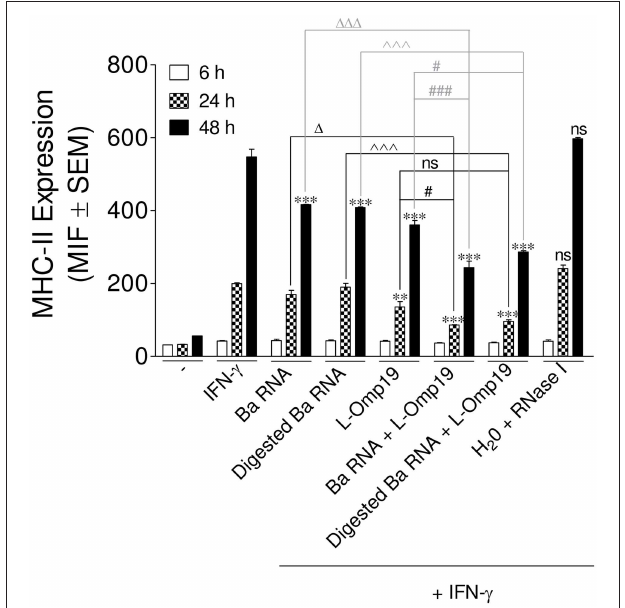
FIGURE 6 | MHC-II down-modulation begins after 24h post-stimuli. THP-1 cells were treated with B. abortus RNA (10 µ g/ml), digested B. abortus RNA, L-Omp19 (1 µ g/ml) or their combination in the presence of IFN- γ for 6, 24, and 48h. Cells treated with RNase I were used as a control. MHC-II expression was assessed by flow cytometry. Bars represent the arithmetic means ± SEM of five independent experiments. MFI, mean fluorescence intensity; ns, non-significant. ** P < 0.01; *** P < 0.001 vs. IFN- γ -treated cells; 1 P < 0.05; 111 P < 0.001 vs. Ba RNA; ∧∧∧ P < 0.001 vs. Digested Ba RNA; # P < 0.05; ### P < 0.001 vs.